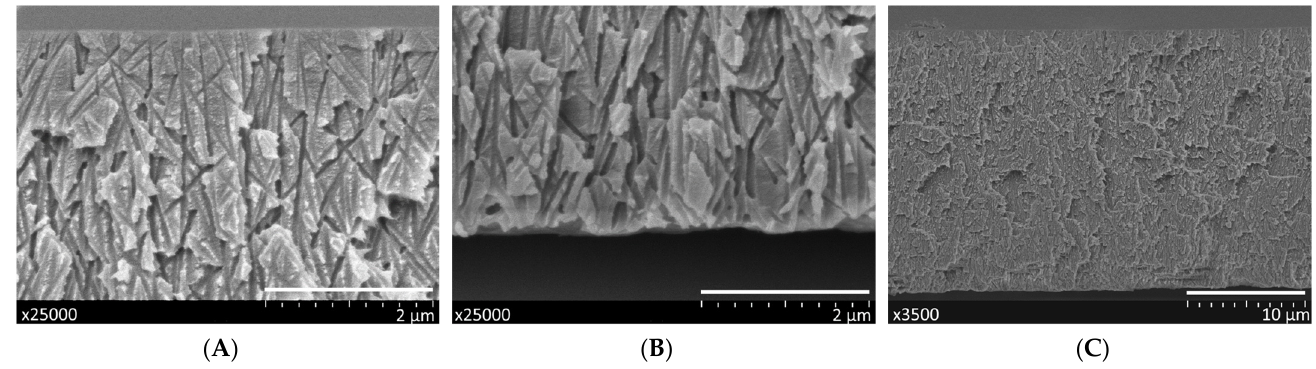
Figure 4. SEM images of side b of membranes TEM-1, TEM-2, TEM-3 and TEM-4 (from the left to the right). Scale bar, 5 μ m.